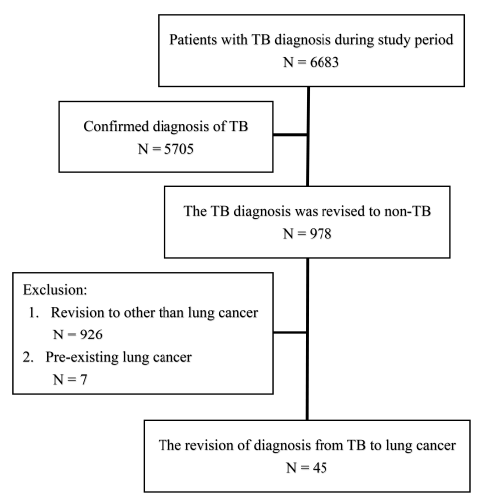
Figure 1. Flow chart of patient recruitment. TB, tuberculosis